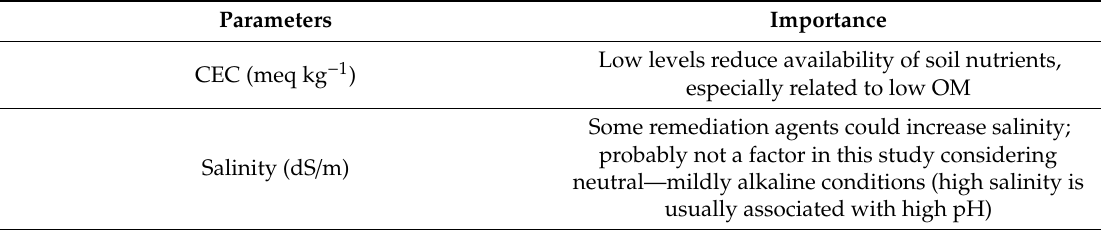
Table 5. Additional parameters to consider in future